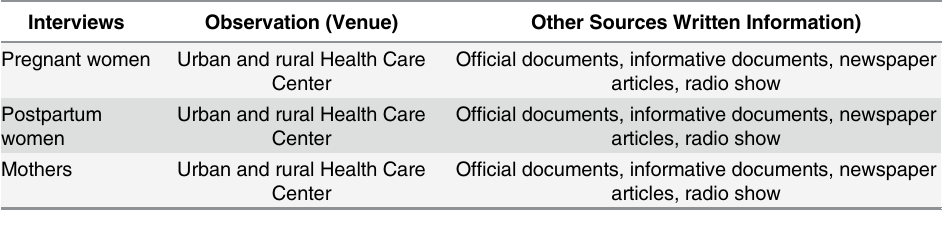
Table 1. Collection of technical